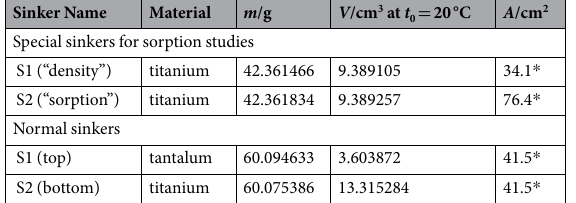
Table 2. Comparison of the special sorption sinkers used in the present testing with the “density sinkers” normally used in the two-sinker densimeter. * Surface area calculated from dimensions and